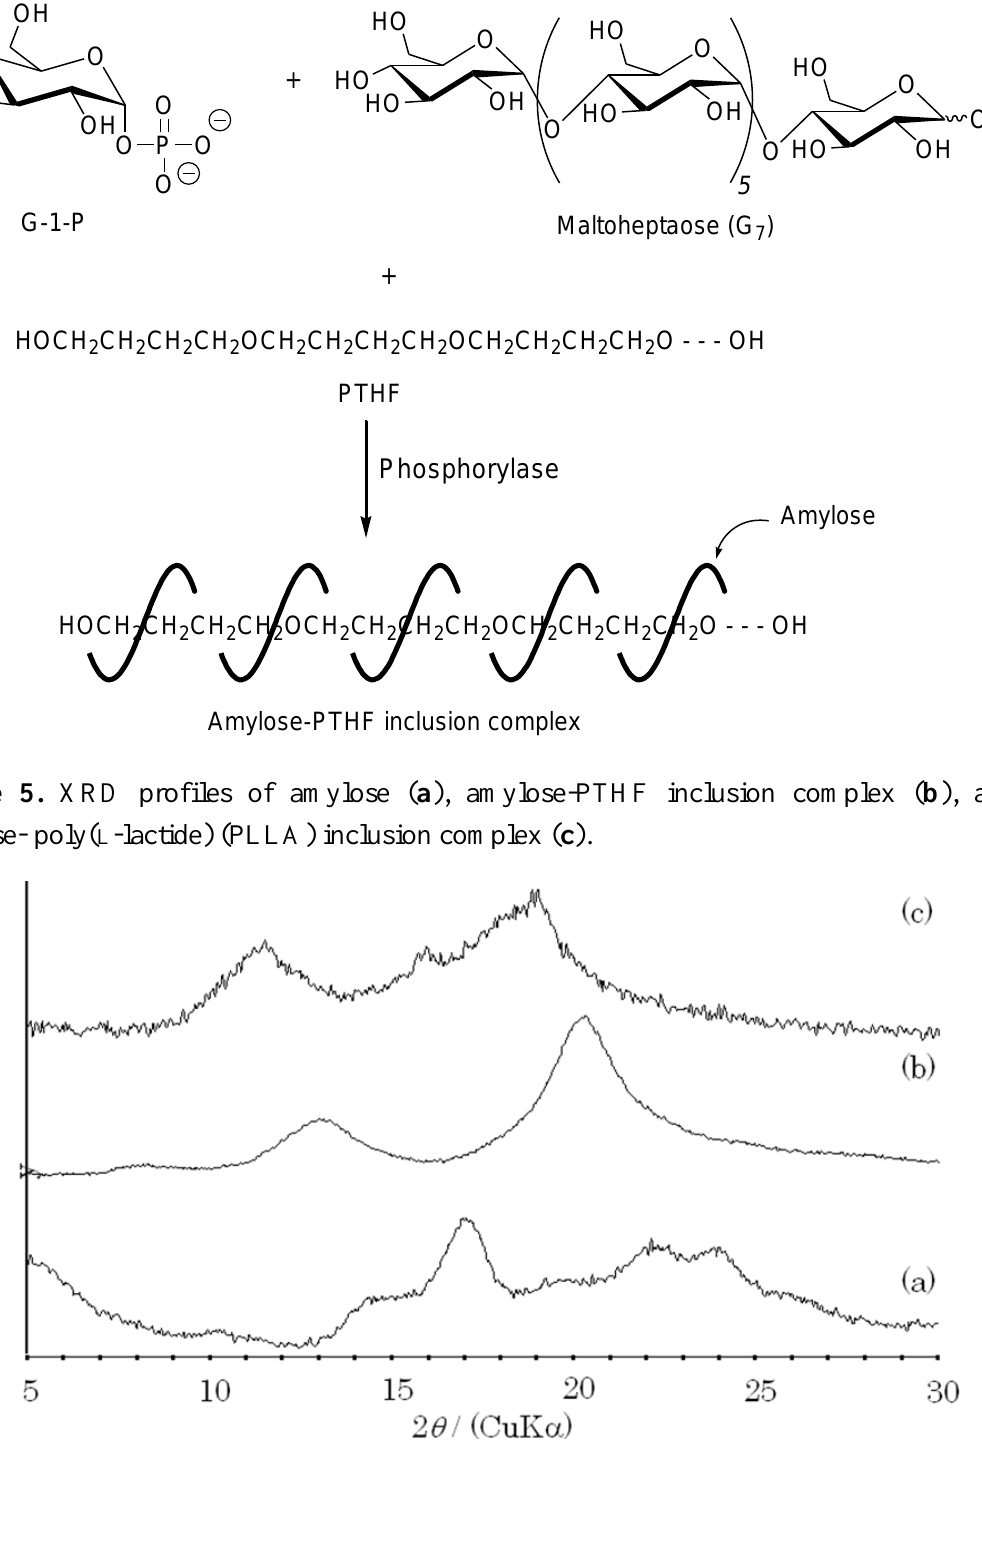
Figure 4. Formation of amylase-poly(tetrahydrofuran) (PTHF) inclusion complex in phosphorylase-catalyzed polymerization in the presence of PTHF.